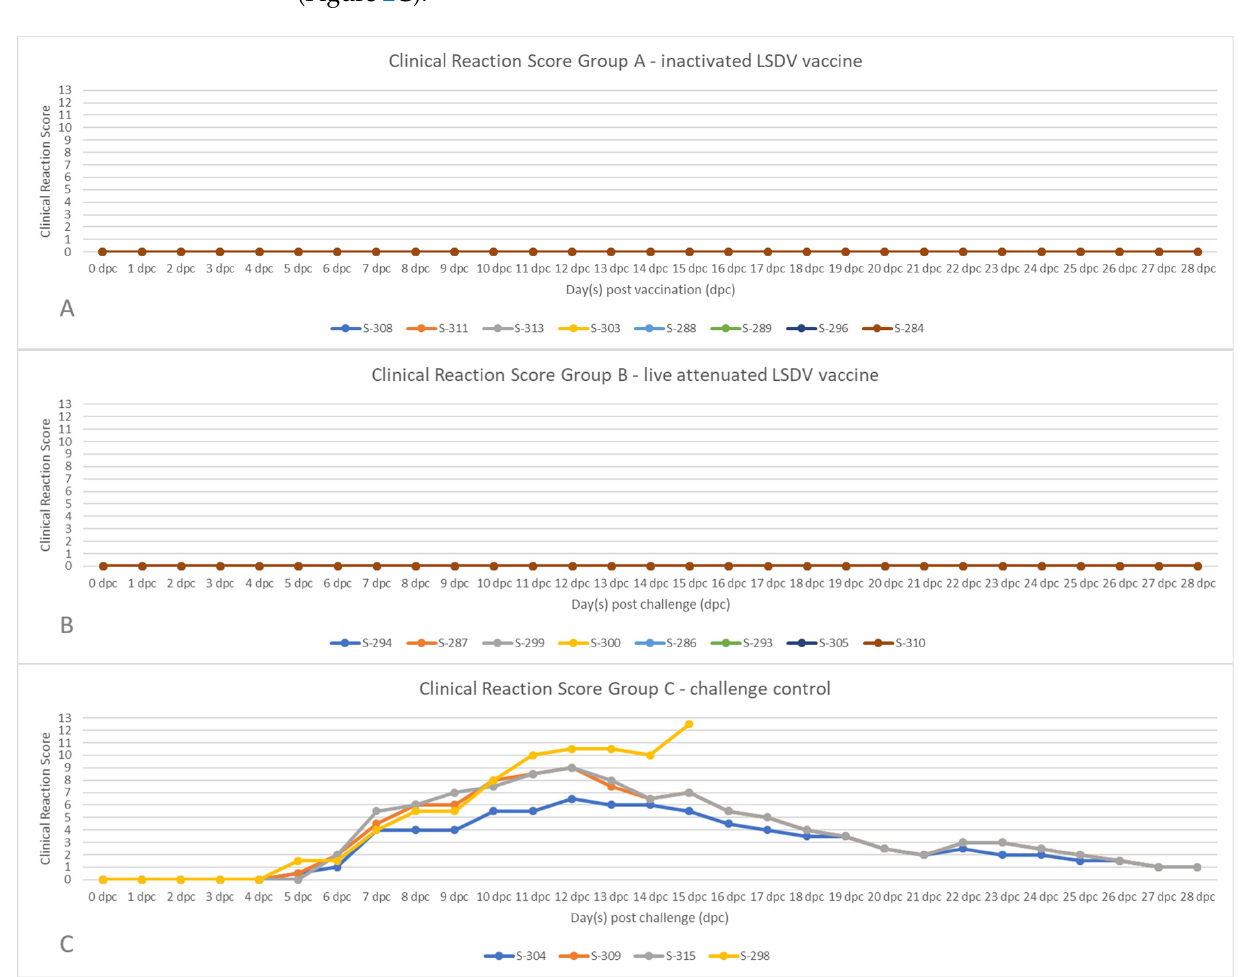
Figure 2. Clinical reaction score after challenge infection with the virulent SPPV-India/2013/ Surankote. After the administration of the challenge virus, the development of clinical signs typical for SPP were examined and clinical reaction score was calculated. ( A ) The animals of group A were vaccinated twice with an inactivated LSDV vaccine candidate before challenge. ( B ) The sheep of group B received a single-shot of the live-attenuated LSDV vaccine strain before challenge. ( C ) The animals of group C served as the unvaccinated challenge control